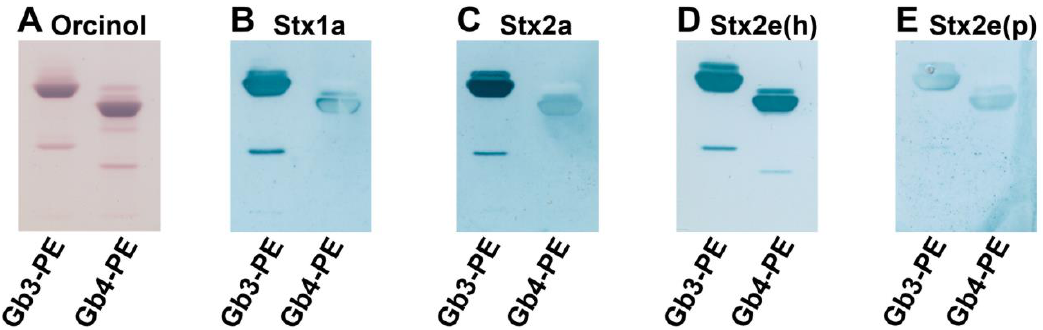
Figure 6. Orcinol stain ( A ) and Stx overlay detection ( B – E ) of TLC-separated neoglycolipids Gb3-PE and Gb4-PE. Stx1a and Stx2a subtypes originated from human EHEC isolates. The two variants of Stx2e subtype derived from human (h) and porcine (p) STEC isolates were differentiated in Stx2e(h) and Stx2e(p), respectively. Amounts of Gb3-PE and Gb4-PE were 5 µg, respectively, for the orcinol stain ( A ) and each Stx overlay assay ( B – E ).